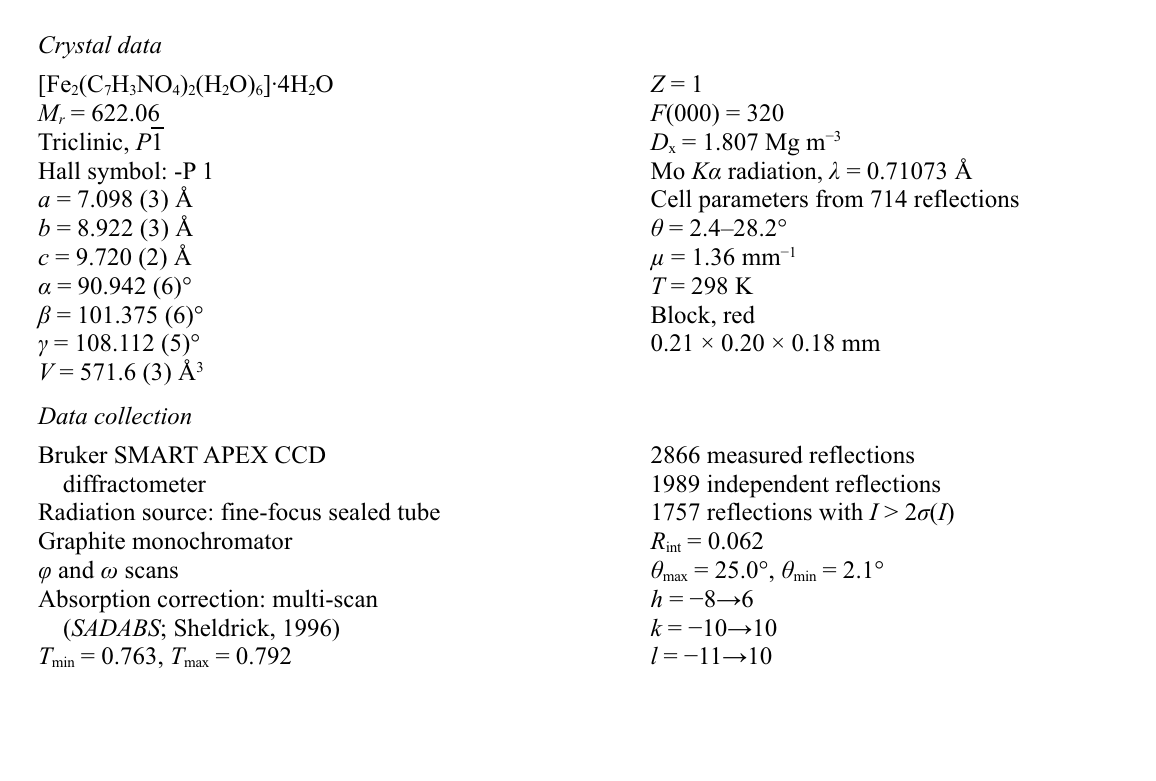
The three-dimensional supramolecular structure of the title compound. Hydrogen bonds are shown by dashed lines. catena -Poly[[[diaquairon(II)]- µ -pyridine-2,5-dicarboxylato- [tetraaquairon(II)]- µ -pyridine-2,5-dicarboxylato]